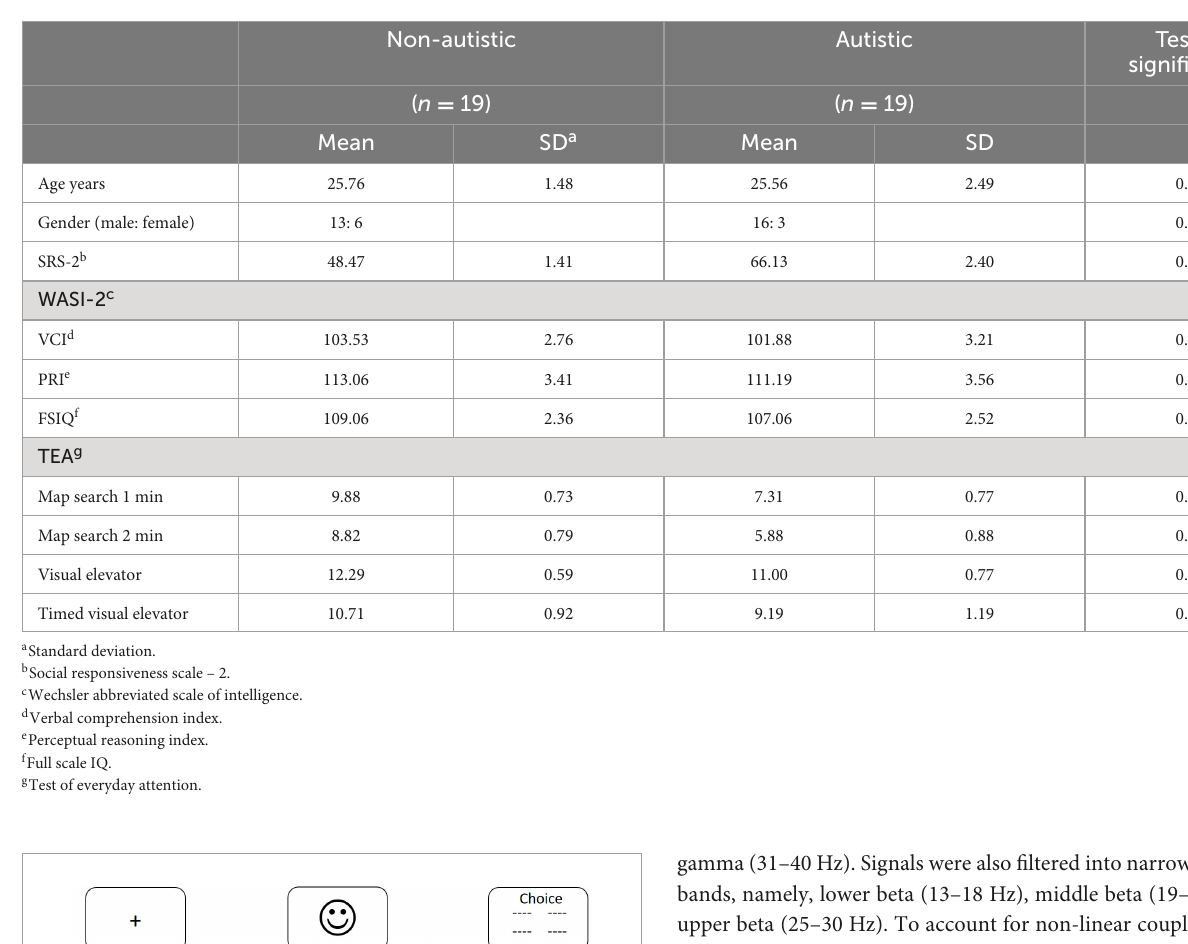
TABLE 1 Participant demographiycs.